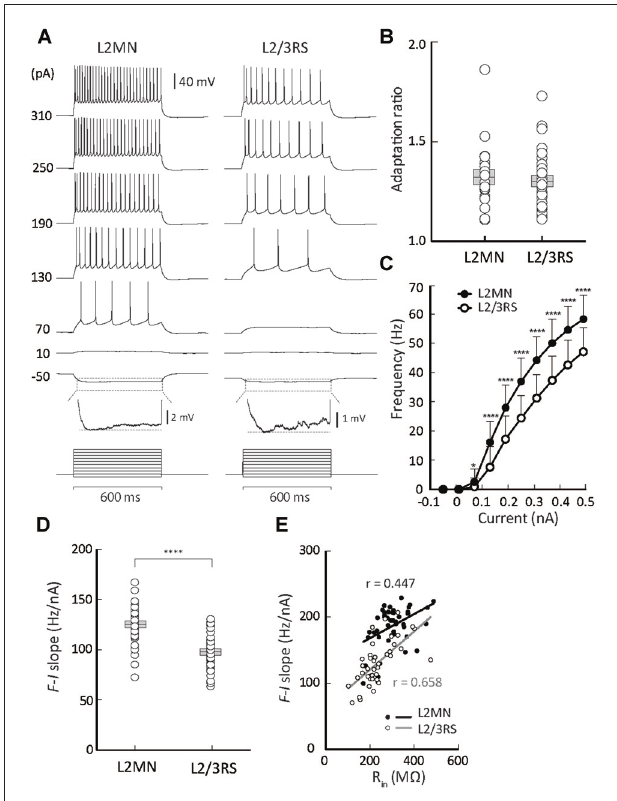
FIGURE 4 | Comparison of firing properties between L2MNs and L2/3RS neurons. (A) Representative recordings from a L2MN and a L2/3RS neuron responding to a family of step currents, as labeled to the left. For both the L2MN and the L2/3RS neuron, the hyperpolarization response marked by the dotted box is further shown in an enlarged voltage scale to illustrate the sag potential. (B) Comparisons of adaptation ratio between L2MNs and L2/3RS neurons. (C) Comparisons of frequency-current relationships between L2MNs (black circles) and L2/3RS neurons (white circles). Error bar = SD; ∗ p < 0.05; ∗∗∗∗ p ≤ 0.0001. (D) Comparison of the slopes of the frequency-current relationship between L2MNs and L2/3RS neurons. Error bar = SEM; p ≤ 0.0001. (E) Correlation between input resistance (R in ) and the slopes of the frequency-current relationship (F-I slope) in L2MNs and L2/3RS neurons. A significant correlation was found for both types of neurons ( p = 0.003 for L2MNs and p < 0.0001 for L2/3RS).